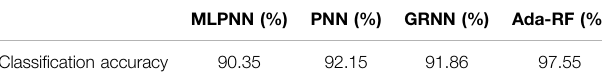
TABLE 8 | Classi fi cation accuracy of different research methods on data